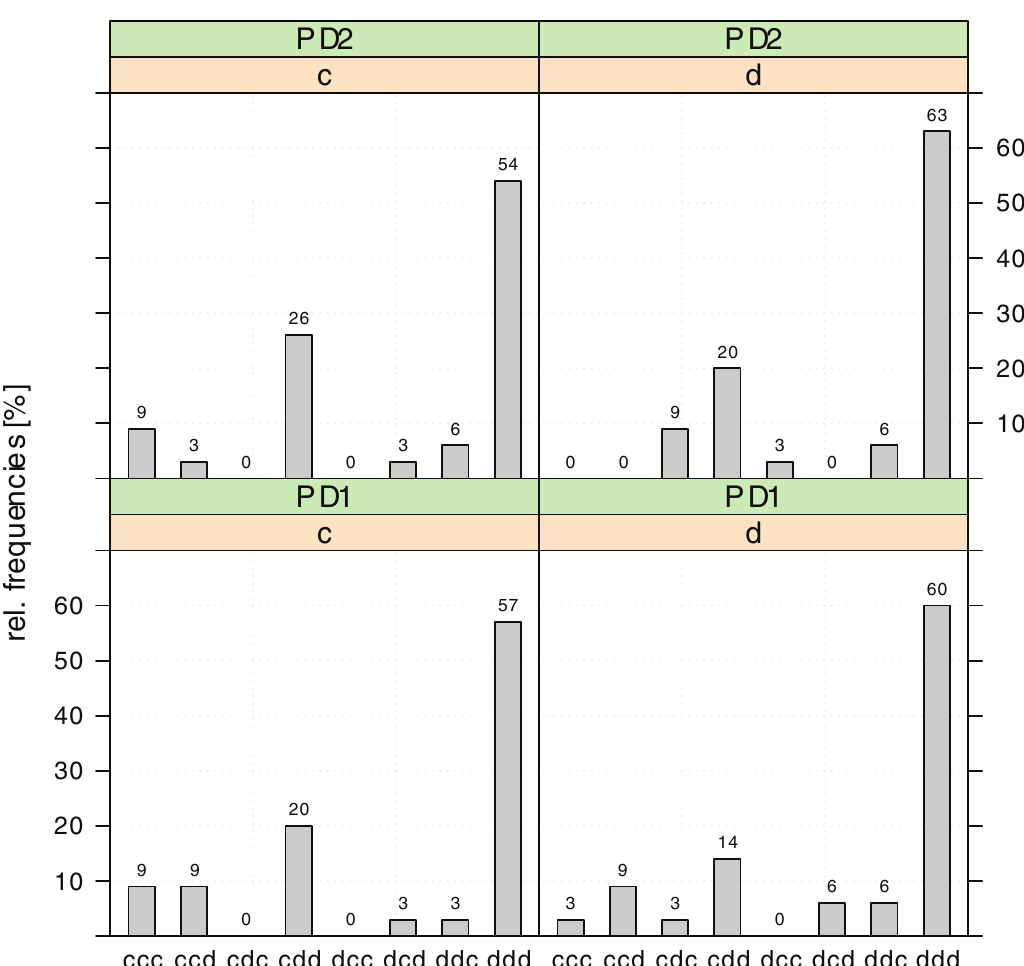
Fig 4. Relative frequencies of individual behavioral patterns over the three